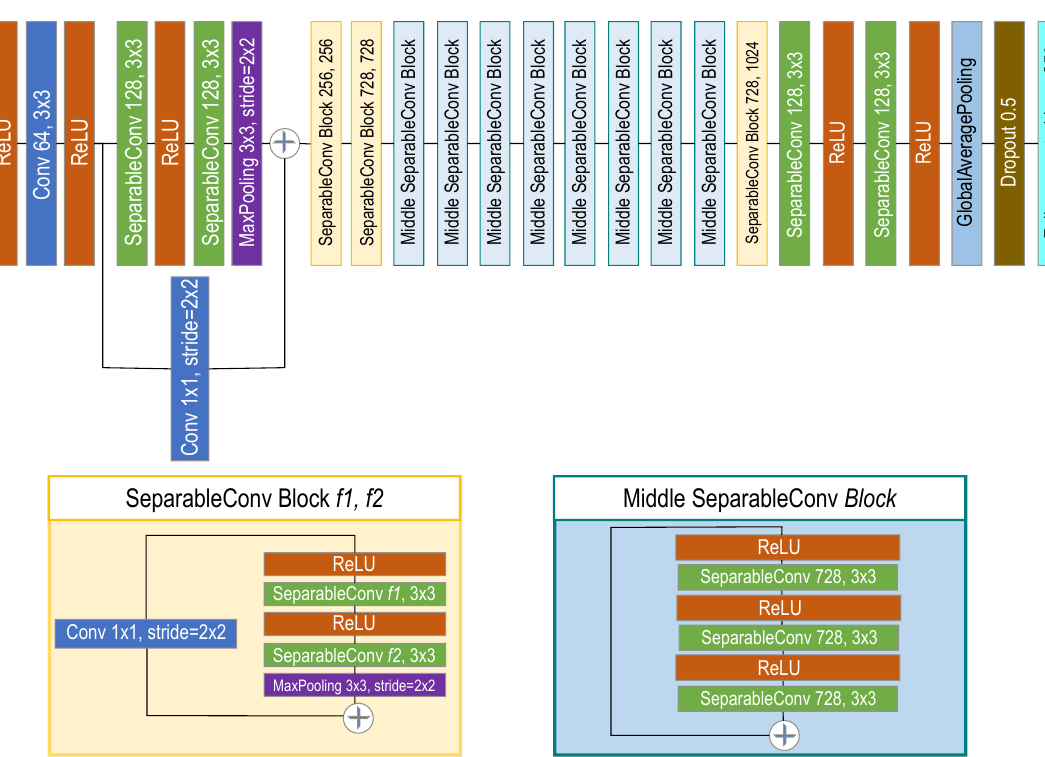
Figure 2. The CoroNet Architecture proposed by Khan et al. [13]. The numbers following the convolutional layers and separable convolutional layers refer to the number of filters and the size of the kernel window. Similarly, the number following the fully connected layers refers to the number of nodes in that layer. Note that all convolutional and separable convolutional layers are followed by a batch normalization layer not shown in the graph.